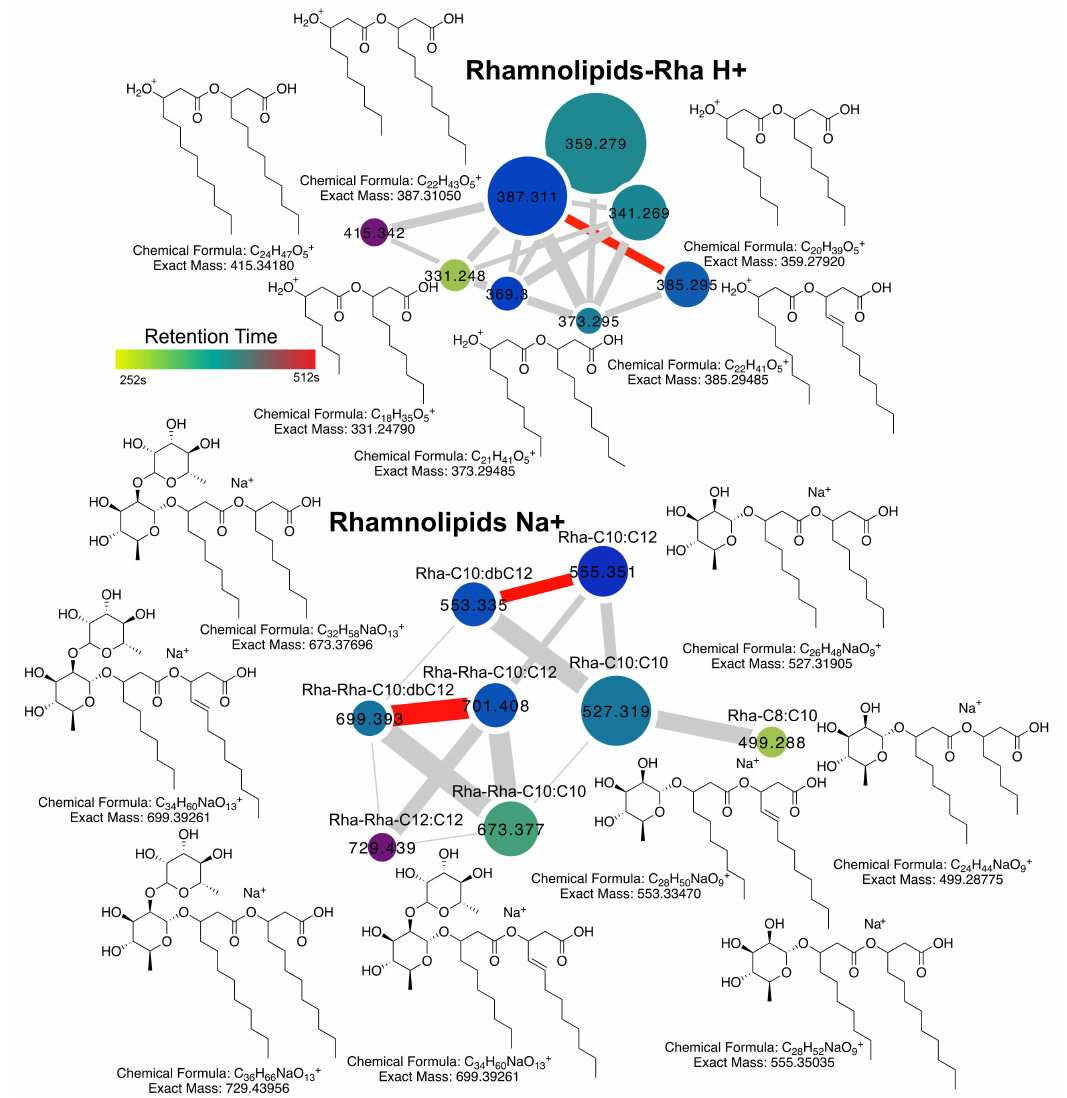
Figure 2. Rhamnolipid diversity from P. aeruginosa clinical isolates. Molecular network and rhamnolipid structures for compounds identified in this study. The network nodes are colored by retention time according to the scale and sized by the number of spectra in the dataset. Edge width in the network is sized by the cosine score. Red edges represent those of a desaturation ( ∆ m / z = 2). The position of the FA double bond is